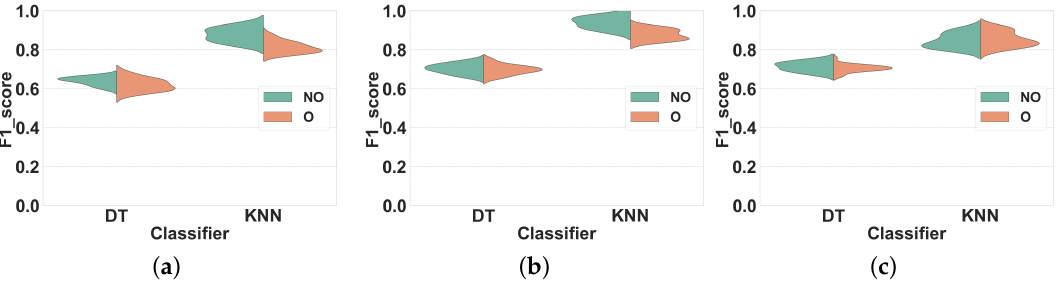
Figure 9. Experiment 3–Subject-independent CV–Dataset 1. ( a ) FS1; ( b ) FS2; ( c ) FS3.